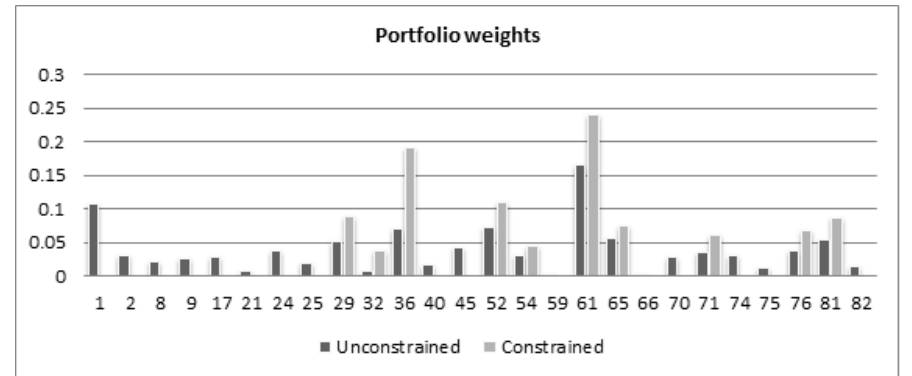
Figure 2. Portfolio